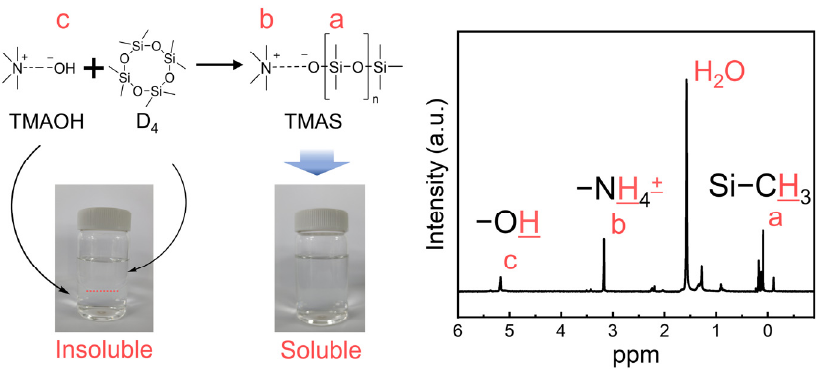
Figure 1. Synthetic pathways and characterization of functional groups from 1 H-NMR spectrum of TMAS.